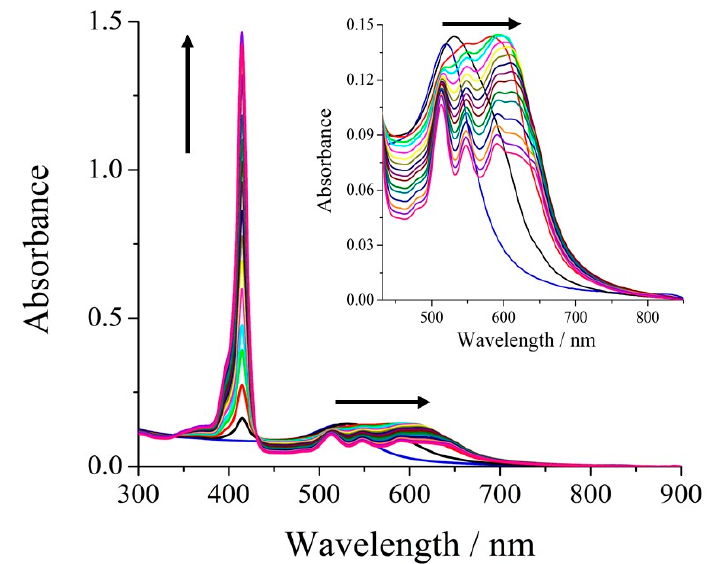
Figure 8. UV–vis absorbance spectra of 100 µ L of an Au NPs aqueous 1.97 × 10 − 7 M solution diluted with 2 mL of CH 3 OH (blue line), and upon the addition of 40 (black line), 80 (red line), 120 (green line), 160 (cyan line), 200 (magenta line), 240 (yellow line), 280 (dark yellow line), 320 (navy line), 360 (purple line), 400 (wine line), 450 (olive line), 500 (dark cyan line), 600 (royal line), 700 (orange line), 800 (violet line), and 900 (pink line) µ L aliquots of a 2.07 × 10 − 5 M porphyrin CH 3 OH solution (final total volume 3 mL). All the spectra were corrected for the volume variation. Inset: expanded scale of the Au NPs plasmon–porphyrin Q-bands